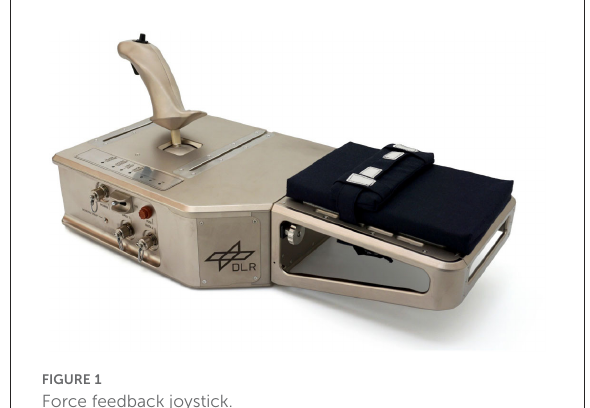
FIGURE1 Force feedback